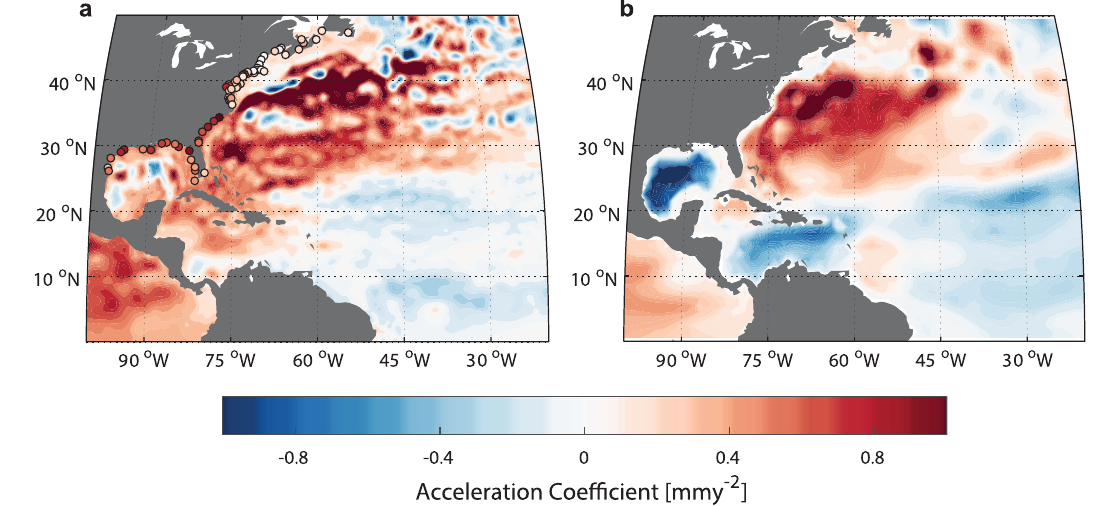
Fig. 3 | Acceleration of mean sea level (MSL) change rates from tide gauges, satellitealtimetry,andstericheightover1993 – 2020.a Quadraticcoef fi cients fi t to satellite altimetry and tide-gauge records (circles; after removing vertical land